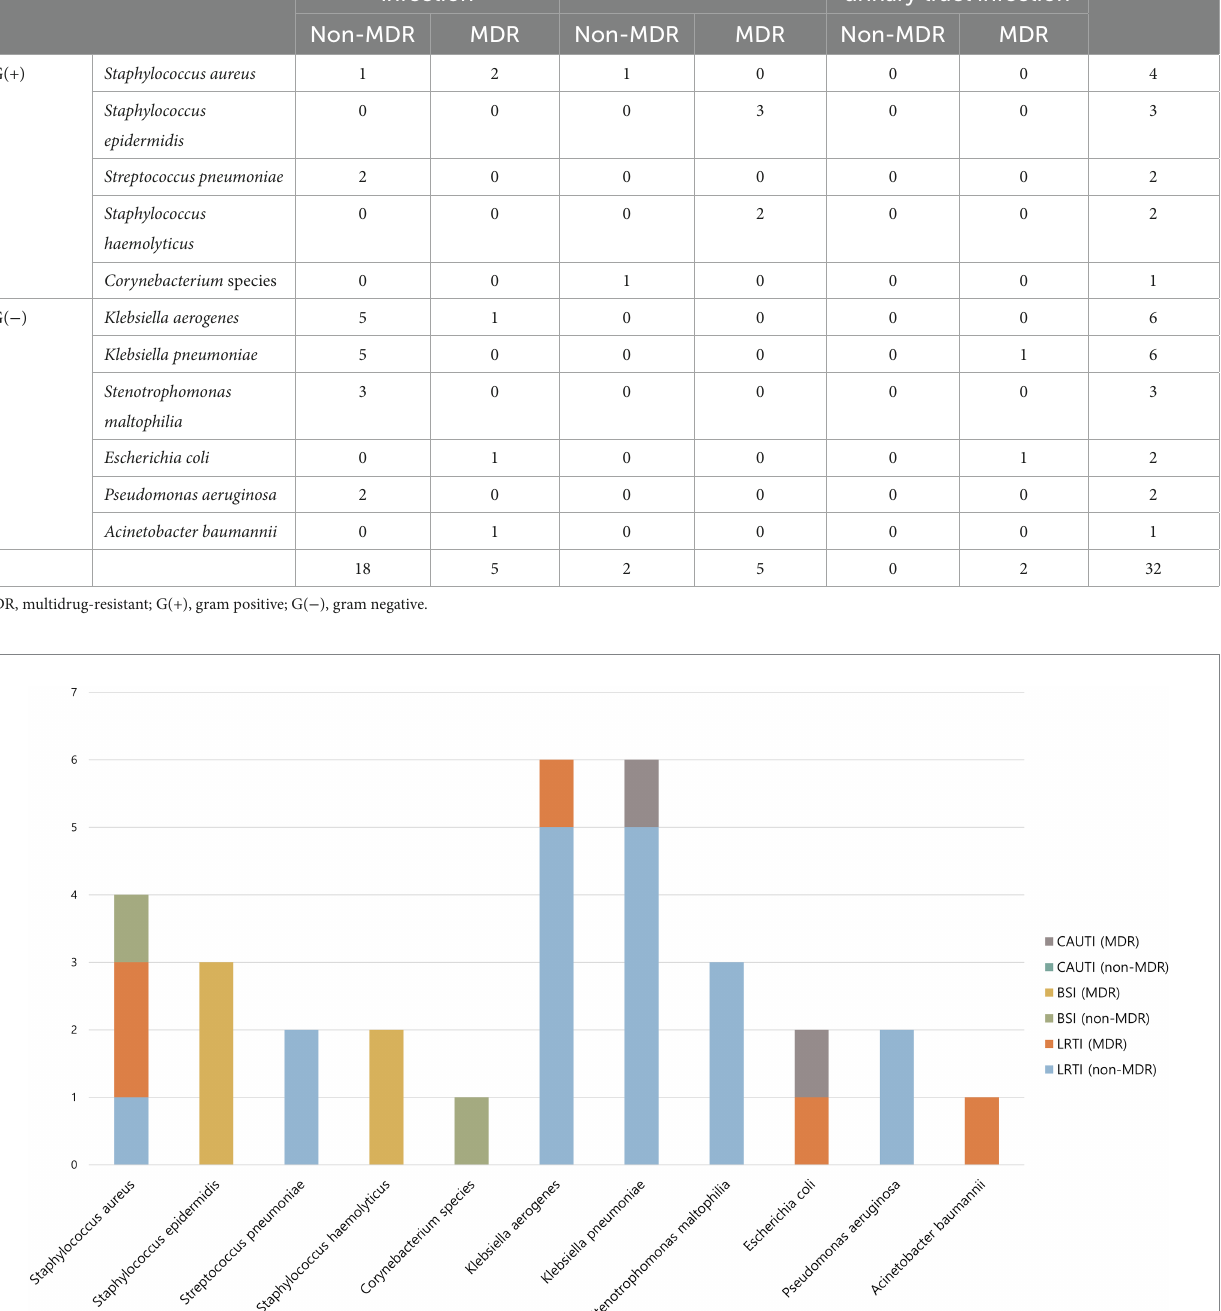
during their ICU stay (45 [85%] patients in the high-risk group and 33 [62%] patients in the low-risk group), the number of ventilator-free days at day 28 were significantly lower in the high-risk group than in the low-risk group: 0 (IQR, 0–18) days versus 21 (IQR, 18–23) days ( p < 0.001). Moreover, the length of ICU stay was significantly longer in the high-risk group than in the low-risk group: 24 (IQR, 10–46)